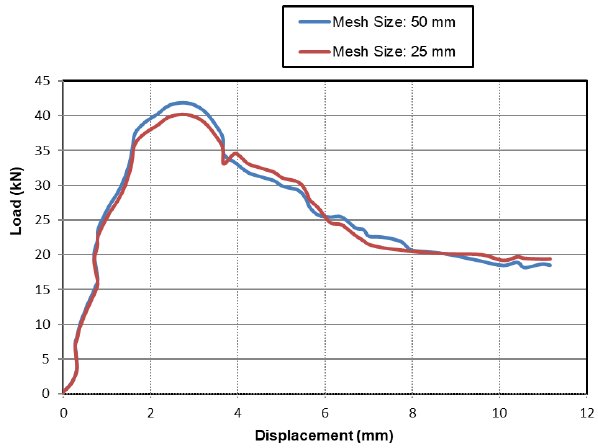
in the finite-element method. The eight-node linear brick